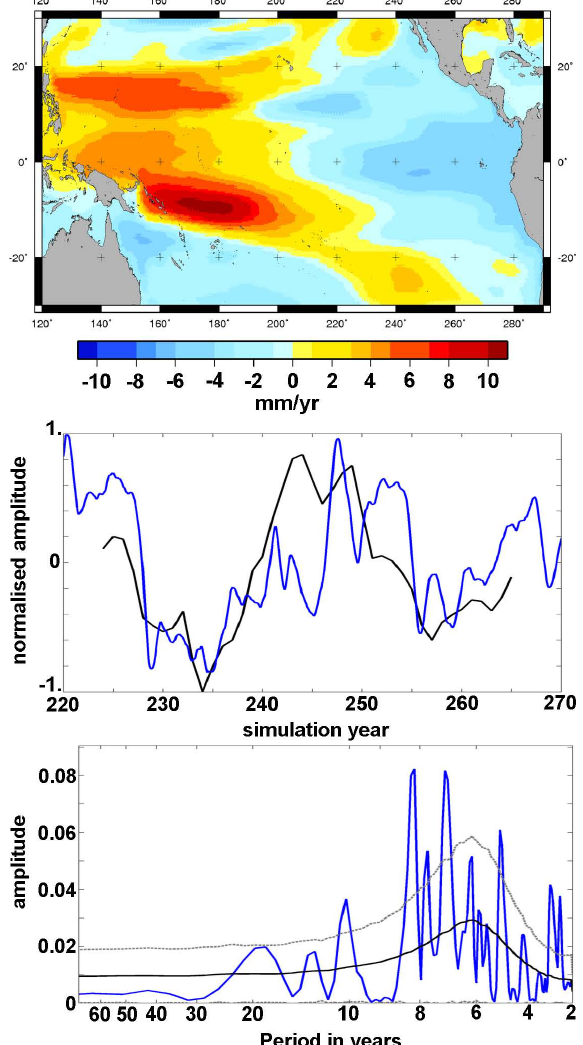
Fig. 8. First rotated EOF of the set of 17-yr trend maps computed with the GFDL control run between years 220 and 280. It explains 43% of the total variance. Top panel: spatial pattern of the EOF Middle panel: the PC is the black curve. The NINO3 index, filtered with a 10-yr running mean and detrended, is superimposed in blue. Bottom panel: NINO3 index power spectrum (in blue) and the best fit AR2 process in black as the null hypothesis. The grey dashed lines indicate the 95% confidence level around the null